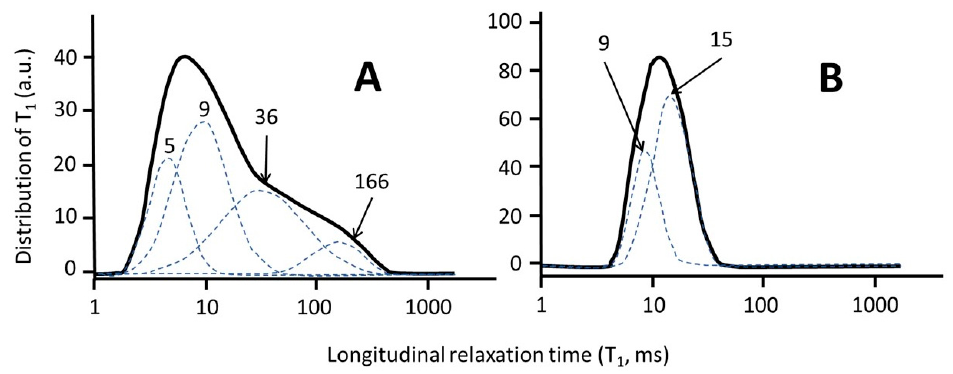
Figure 15. ( A ). Relaxogram of dissolved organic matter after interaction with kaolinite. ( B ). Relaxogram of dissolved organic matter after interaction with montmorillonite. The dashed lines represent the different T 1 components as obtained by deconvolution. This figure has been reproduced from Reference [84] with the permission of Elsevier.